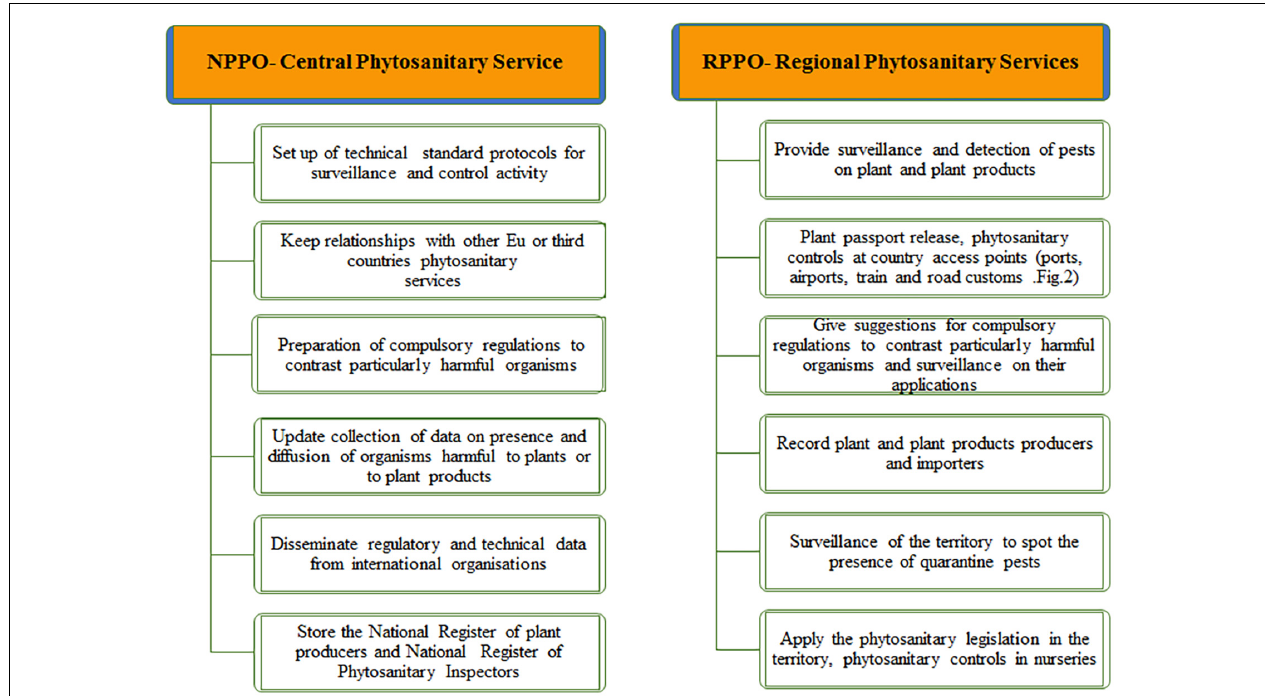
FIGURE 3 | Roles of Italian national and regional phytosanitary